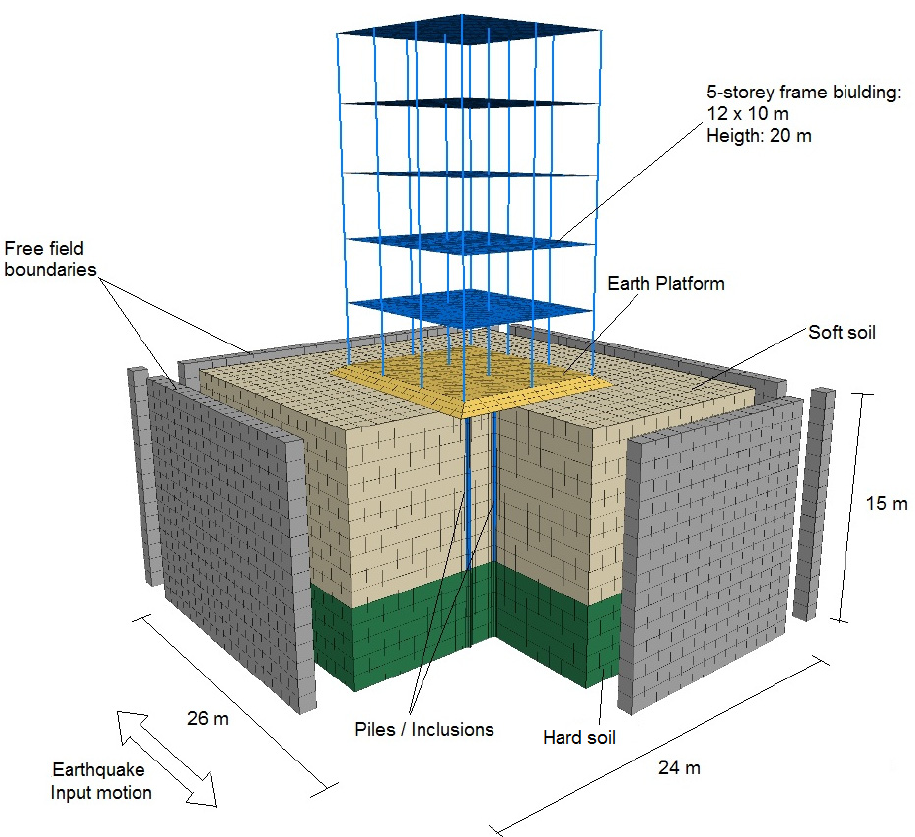
Figure 4. Geometry of the numerical model.